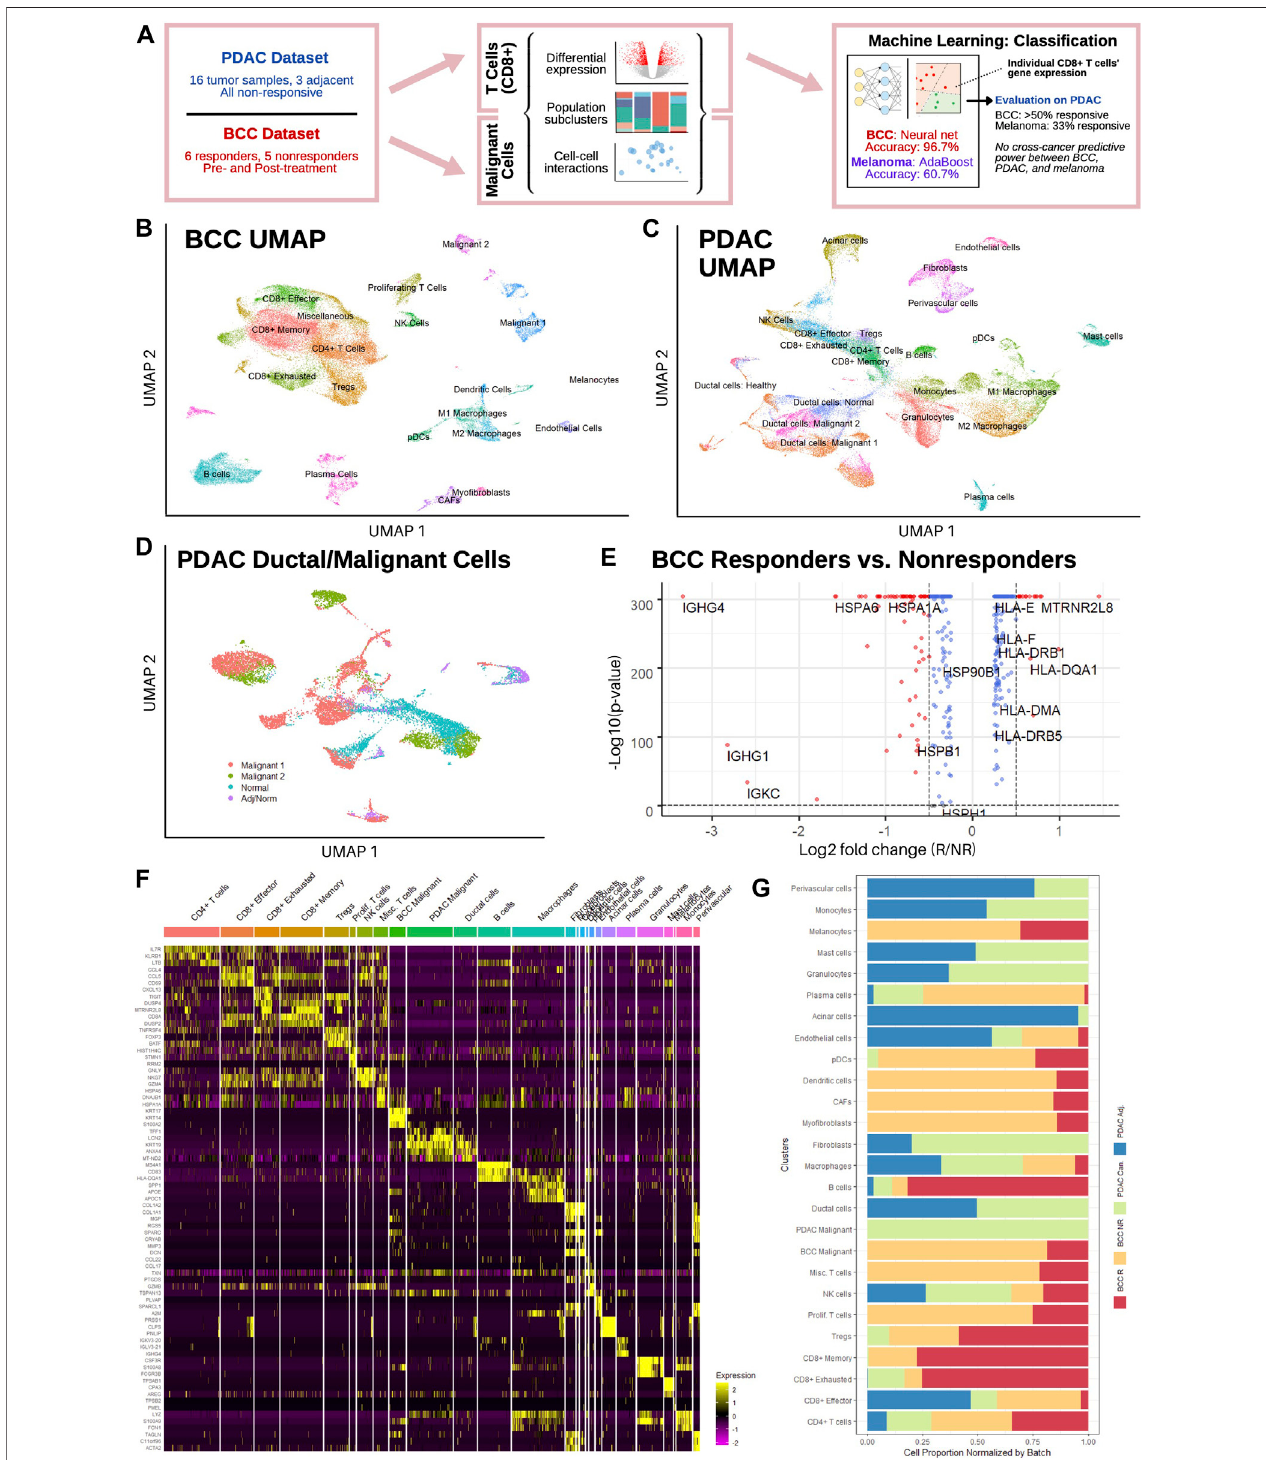
FIGURE 1 | Single-cell sequencing reveals distinct T cell subpopulations in BCC and PDAC and ductal cell subpopulations in PDAC. (A) Work fl ow diagram. (B,C) Dimensional reduction of (B) BCC and (C) PDAC TME. (D) Dimensional reduction of PDAC ductal cells. (E) Differential gene expression between BCC responders and nonresponders;positivefoldchangeindicatesgreaterexpressioninresponders. (F) Single-cellresolutionheatmapoftopthreedifferentiallyexpressedgenespercluster inmergedBCCandPDACdataset. (G) Normalizedproportionofcellsineachclusteridenti fi edin (F) thatbelongtoBCCresponders(BCCR),BCCnonresponders (BCC NR), PDAC tumors (PDAC Can.), and adjacent PDAC samples (PDAC Adj.).